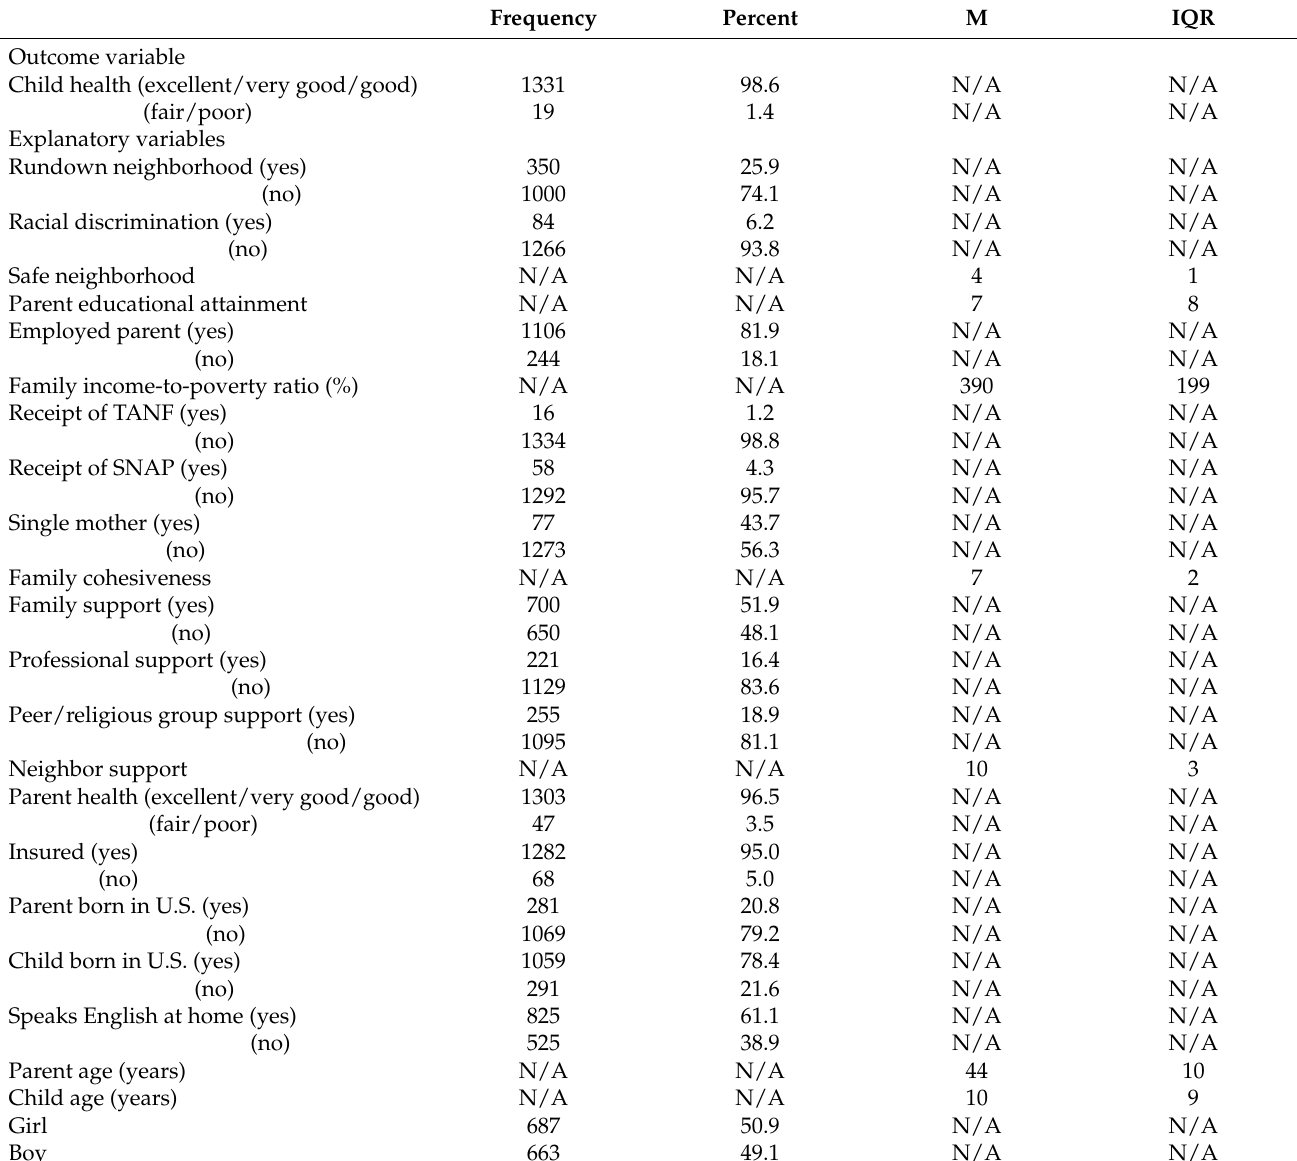
Table 1. Descriptive statistics of ethnic Asian children ( n =